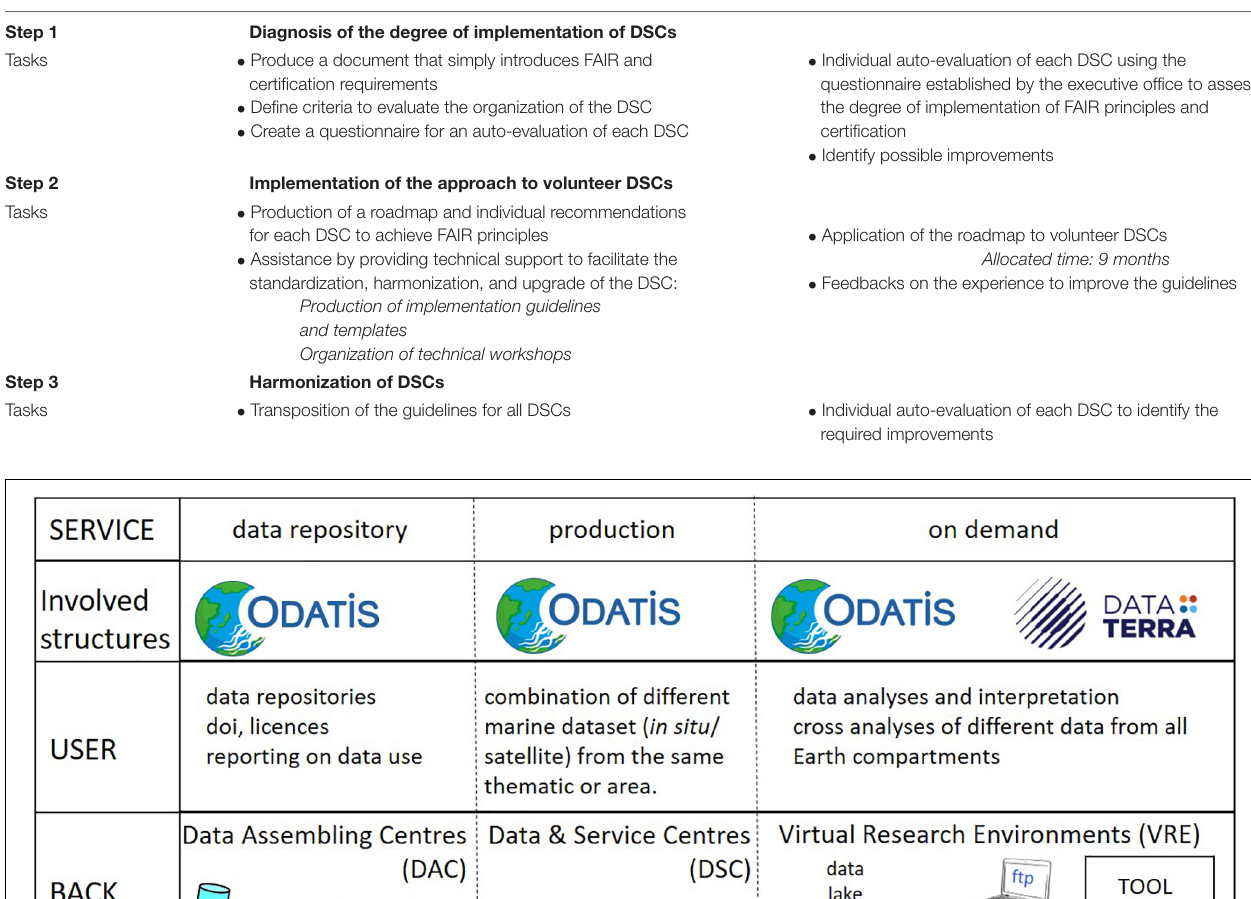
TABLE 2 | Tasks identified to implement FAIR and CoreTrustSeal requirements to guide ODATIS data and service centers toward certification. Structure level